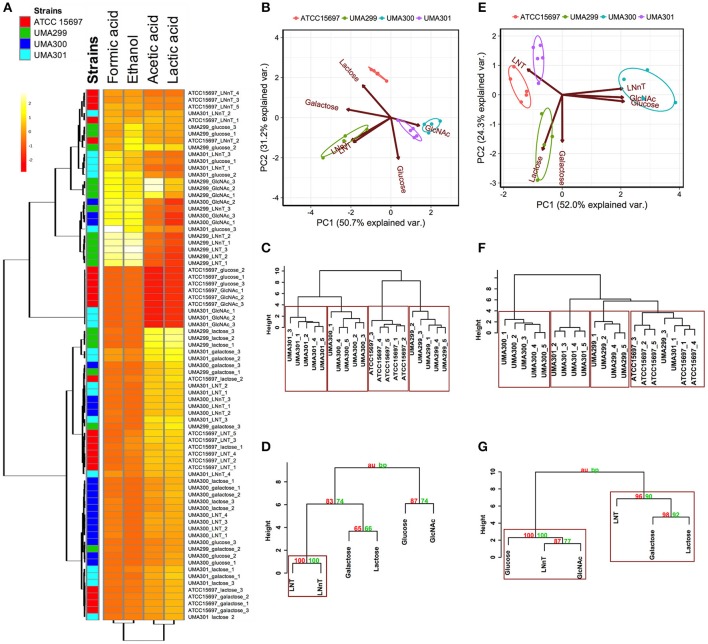
Analysis of B. longum subsp infantis strains secreted fermentative endproducts while utilizing milk carbohydrates. Panel (A) shows metabolites secreted by B. infantis strains for each carbohydrate clustered by Euclidean distance calculated with MetaboAnalyst 3.0. The scaling was performed by mean-centering and dividing by the standard deviation of each metabolite. The red denotes lower concentrations of the metabolite with yellow approaching higher concentrations. Panels (B,E) display the 2D-principal component analysis (PCA) plot depicting acetic acid to lactic acid ratios and acetic acid to lactic acid to formic acid ratios respectively. The arrows in PCA plot represent the correlation of the variables with the principal components (PC1 and PC2). Points represent the scores of each component grouped as biological replicates. The ellipses for each strain incorporate 68% of the normal probability of the scores for corresponding strains. Panels (C,F) are hierarchical clustering dendrogram of strains according to acetic acid to lactic acid ratios and acetic acid to lactic acid to formic acid ratios using the Ward method and Euclidean distance. The y-axis measures the closeness of either individual strains or their calculated clusters. Panels (D,G) represent hierarchical clustering based on p-values calculated with multiscale bootstrapping between acetic acid to lactic acid ratio and acetic acid to lactic acid to formic acid ratio. The y-axis measures the closeness of either individual substrates or clusters according to two metrics: Approximately Unbiased p-value (AU in red) and Bootstrap Probability value (BP in blue). Clusters exhibiting AU values >95% are highlighted by rectangles.